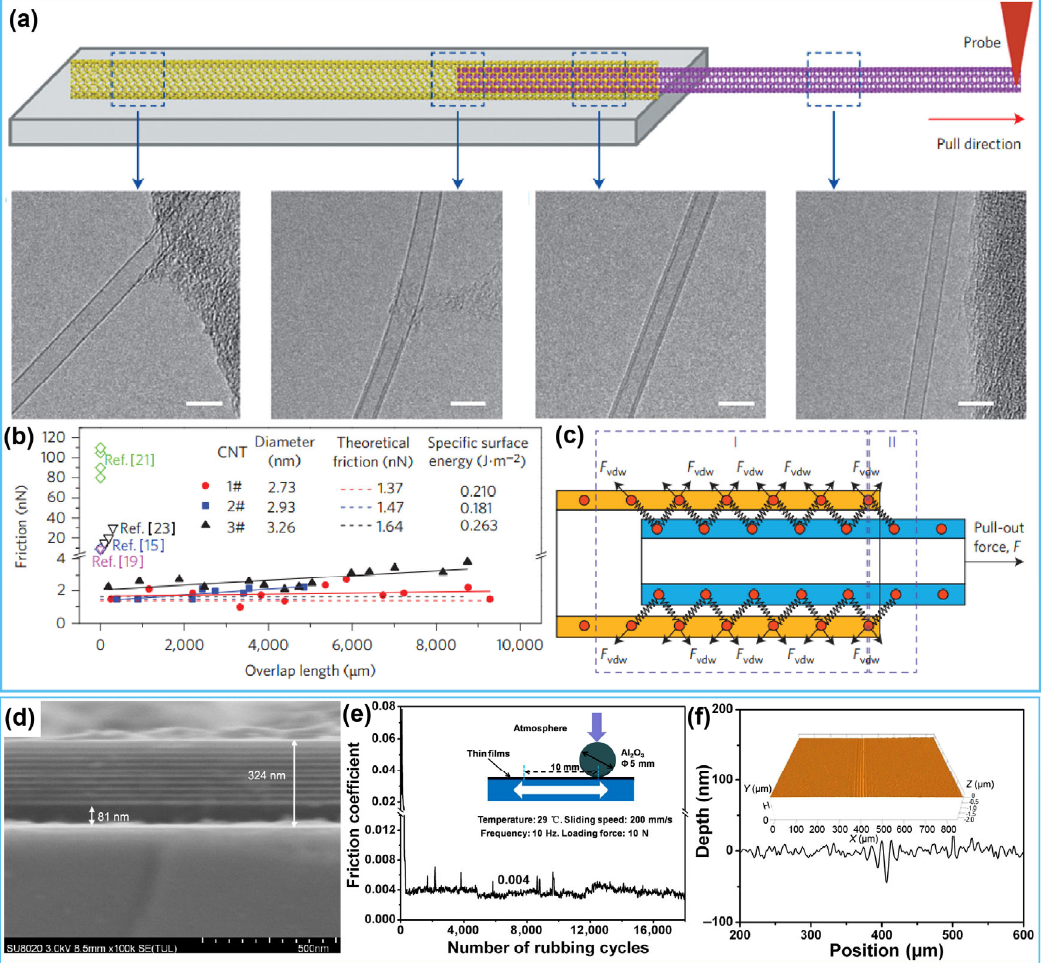
Fig. 6 (a) Sketch map of the pulling out process of the inner layer from double-walled CNTs, and TEM images of different part of double-walled CNTs during the pulling out process. (b) Intershell friction force of three double-walled CNTs with different outer size. (c) Schematic of the interfacial interaction between the inner and outer part of double-walled CNT. Reproduced with permission from Ref. [79], © Springer Nature 2013. (d) SEM image of the prepared 3D hierarchical structure. (e) Friction coefficient and (f) wear track of the as-prepared coating in air under 10 N. Reproduced with permission from Ref. [81], © Elsevier Ltd